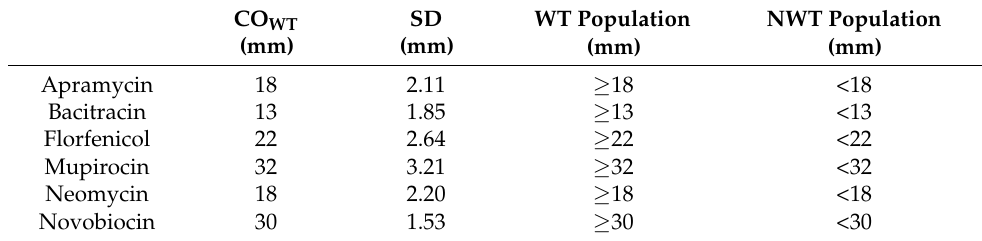
Figure 2. Distributions of inhibition zone diameters for six antibiotics with no established breakpoints for S. coagulans and corresponding cut-off value (CO WT ). The CO WT value (dashed orange lines) was calculated using the Normalized Resistance Interpretation (NRI) method. Grey columns represent the distribution of zone diameters; the green line indicates the NRI-generated normalized distribution of the putative WT populations. Table 2. Cut-off (CO WT ) values of S. coagulans for six antibiotics that have no breakpoints established by CLSI or EUCAST. The CO WT values were determined based on the distributions of inhibition zone diameters for 27 S. coagulans isolates by the NRI